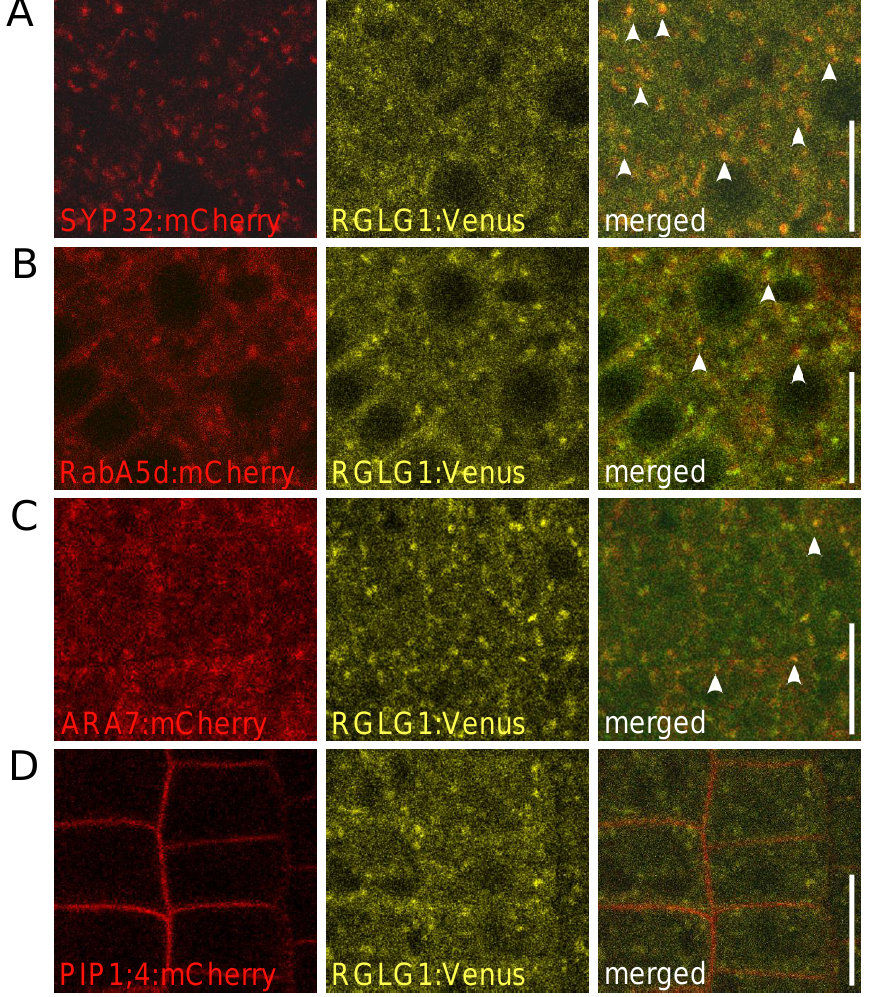
Figure 2. RGLG1::RGLG1:Venus (yellow) co-expressed with UBQ10::SYP32:mCherry ( A ; red) UBQ10::RabA5d:mCherry ( B ; red), UBQ10::ARA7:mCherry ( C ; red), and UBQ10::PIP1;4:mCherry ( D ; red). Images show root meristem epidermis cells at 6 days after germination. Arrowheads: co-localization of reporter signals. Size bars: 10 μm.